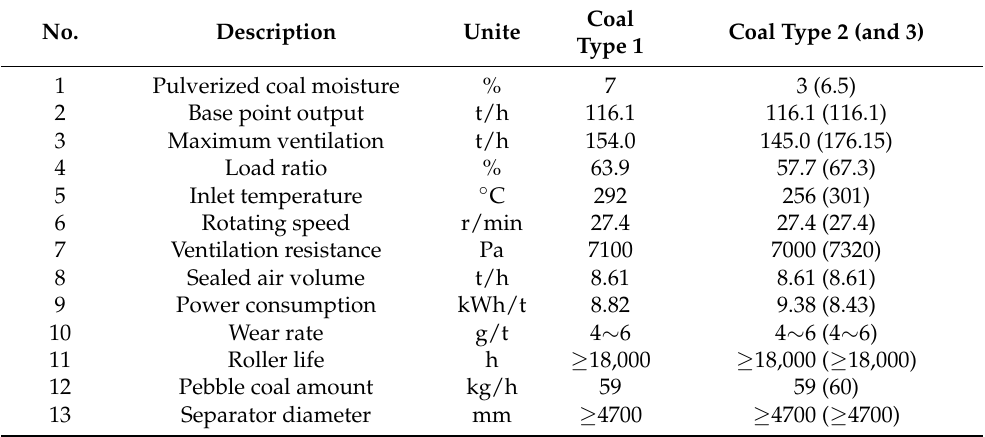
Table 4. The main performance parameters of CMO dataset with different types of coal.